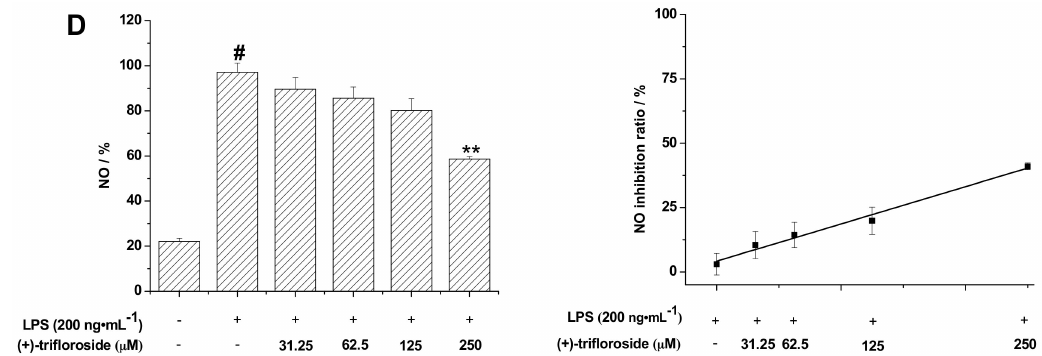
Figure 4. Inhibition of LPS-induced NO in microglial BV-2 cells and the NO inhibition rate of ( A ) loganic acid; ( B ) swertiamarin; ( C ) gentiopicroside; and ( D ) trifloside. BV-2 cells were treated with the indicated concentrations of ( ± )-glycosides and LPS (200 ng/mL) for 24 h. The NO content in the media was measured and the amount of NO in the LPS (200 ng/mL) group was set as 100%. The data is presented as the mean ± SD from three independent experiments and the differences between the mean values were assessed by the Student’s t -test: # p < 0.05 compared to the control group; * p < 0.05, ** p < 0.01, and *** p < 0.001 compared to the LPS group.